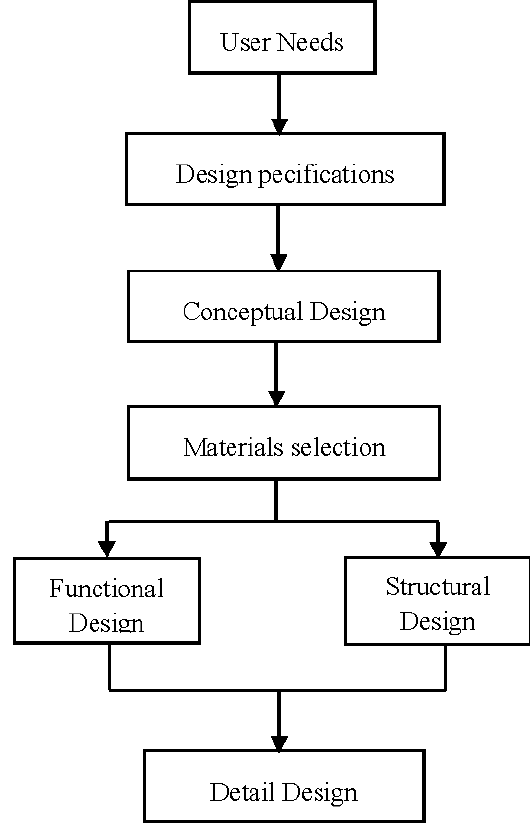
Figure 2. Design processes involved within the shading